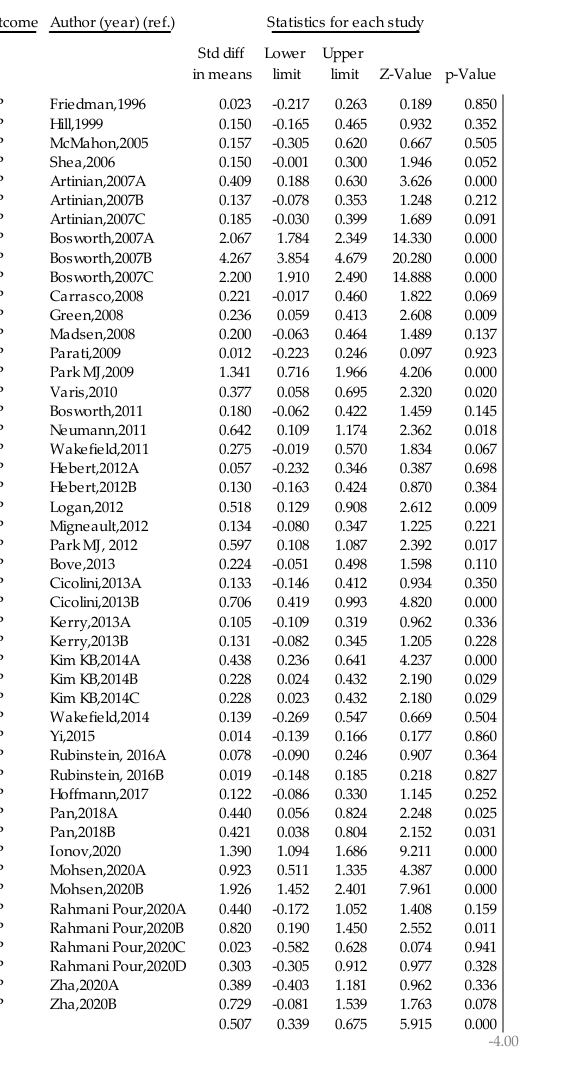
Figure 5. A forest plot of standardized mean difference in systolic blood pressure. Note: point estimate of individual study ( ● ), summary effect size ( ◆ ); SBP, systolic blood pressure; UC, usual care; RBPM, remote blood pressure monitoring.